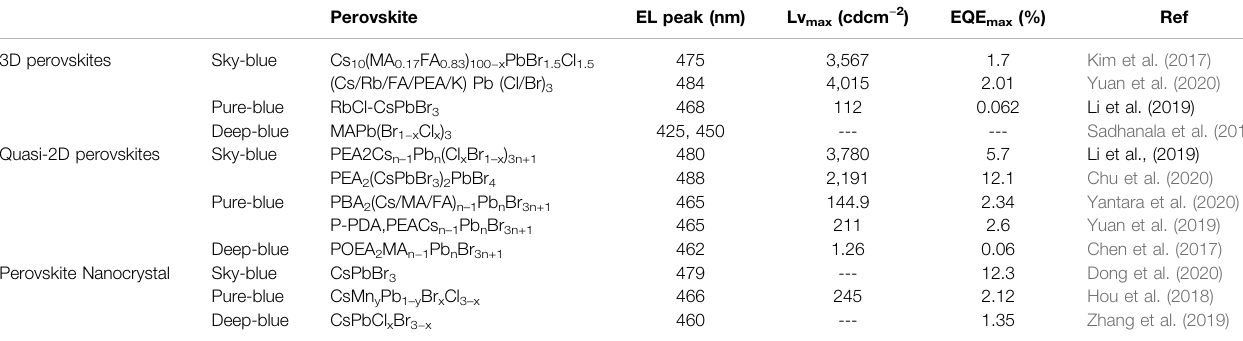
TABLE 1 | Research progress of PLEDs based on 3D, Quasi-2D perovskites and perovskite nanocrystals. Perovskite EL peak